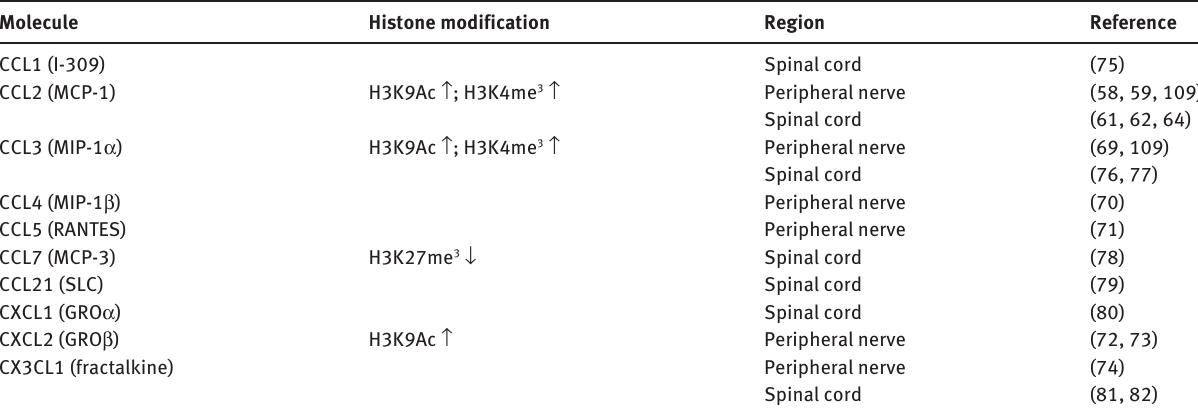
Table 1 Epigenetic induction of chemokines contributing to neuropathic